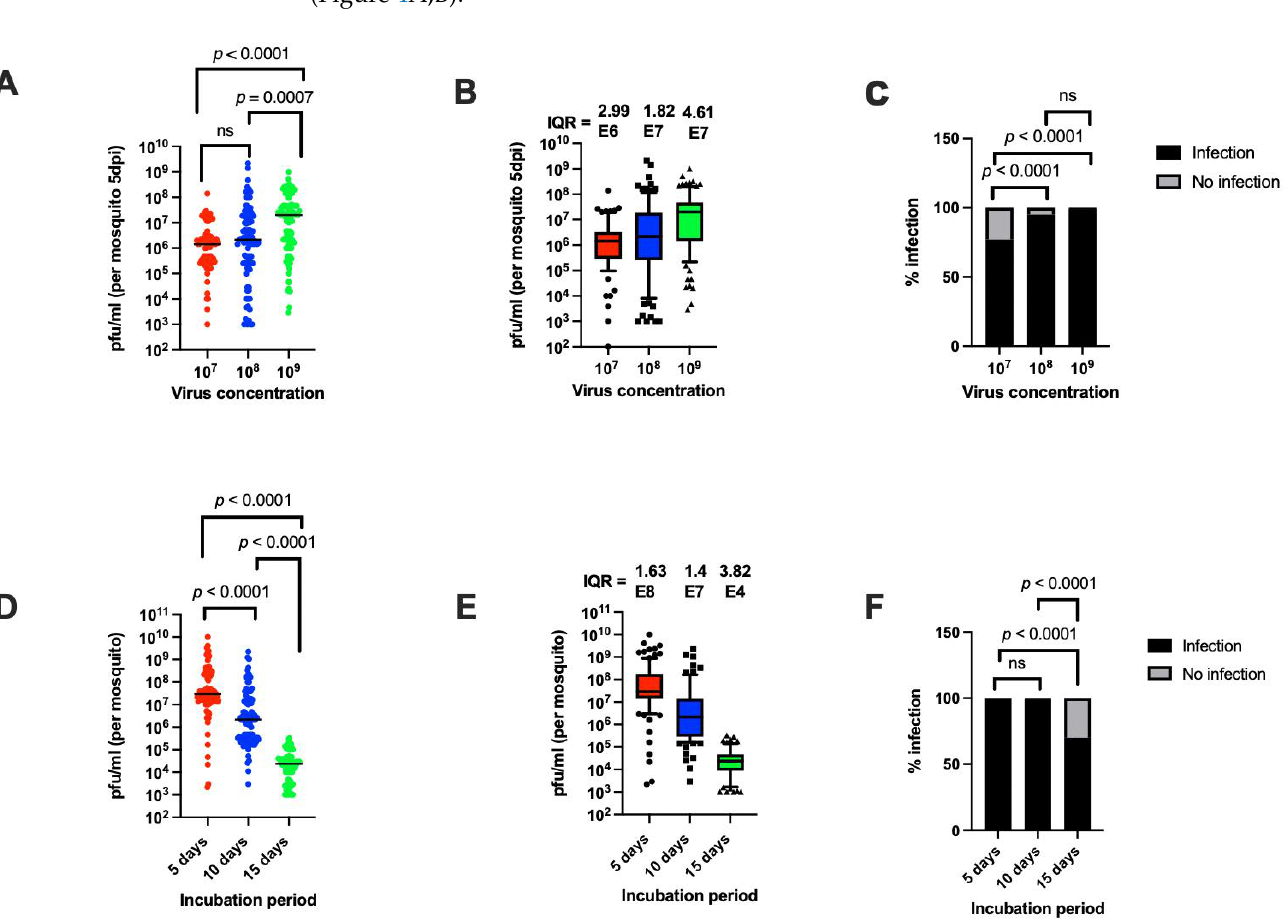
Figure 4. Oral infection of Ae. aegypti using different virus concentrations or incubation periods. ( A ) Titers of mosquitoes at 5 days PBM, after being allowed to feed on blood containing different virus concentrations. ( B ) The use of IQR as a measure of variation. The dataset used in panel ( B ) is the same as in ( A ). ( C ) Prevalence of infection of different mosquito strains after oral infection with different virus concentrations. Sample size was 100 per treatment. ( D ) Titers of orally infected mosquitoes after different incubation periods. ( E ) The use of IQR as a measure of variation. The dataset used in panel ( E ) is the same as in ( D ). ( F ) Prevalence of infection of mosquitoes with different incubation periods. Sample size was 100 per treatment. Statistical analysis was performed as described for Figure